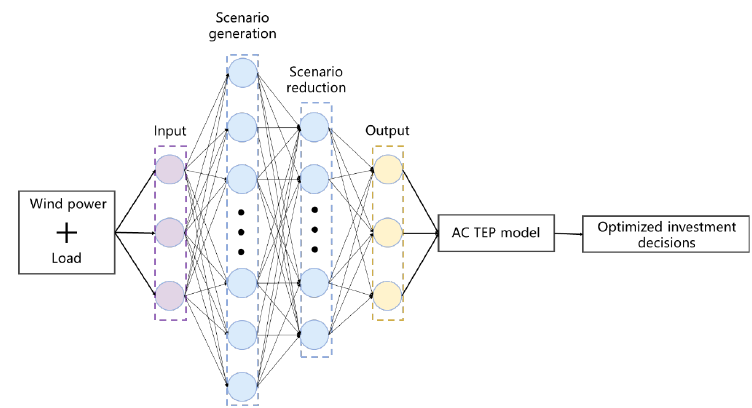
Figure 2. Flow diagram of the algorithm.